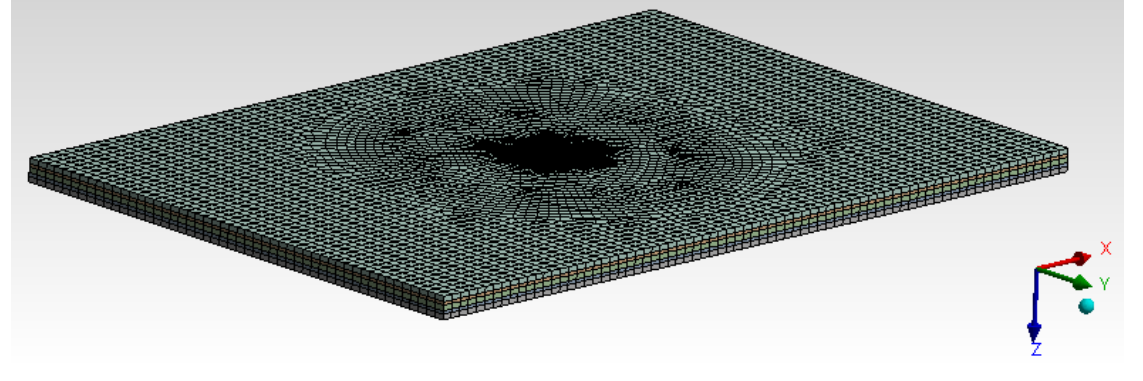
Figure 15. Mesh generation.